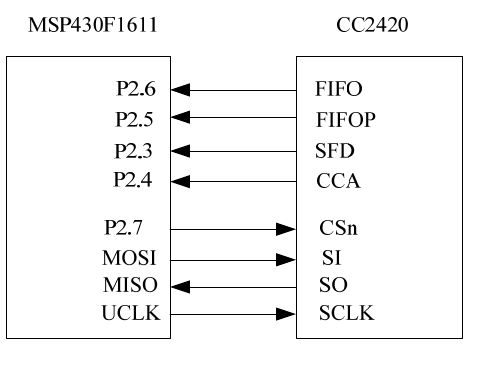
Figure 5. Interface circuit of the ZigBee module.